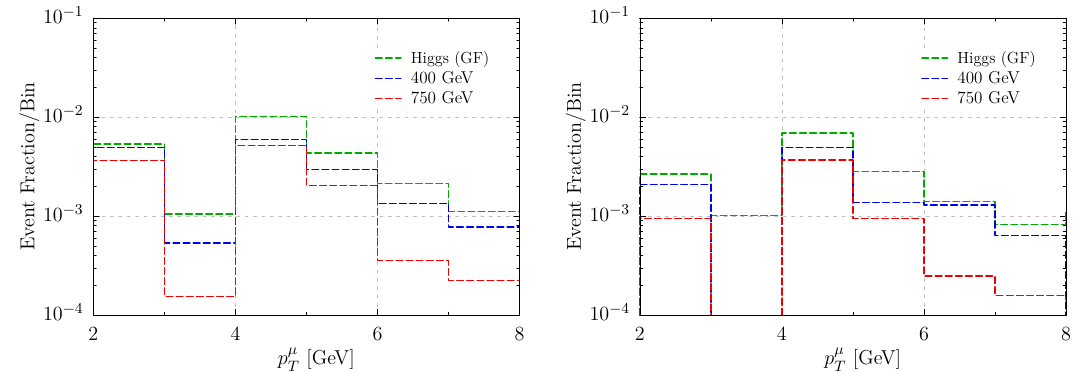
Figure 8. Distributions for the reconstructed p T of third-hardest (left) and fourth-hardest (right)